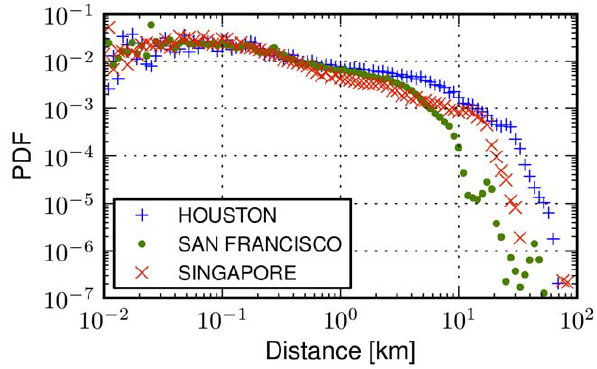
Figure 3. Urban movement heterogeneities. The probability density function (PDF) of human displacements in three cities: Houston, San Francisco and Singapore (for 47, 112 and 79 thousand transitions, respectively). Common trends are observed, e.g., the probability of a jump steadily decreases after the distance threshold of 100 meters, but the shapes of the distributions vary from city to city, suggesting either that human movements do not exhibit universal patterns across cities or that distance is not the appropriate variable to model them.